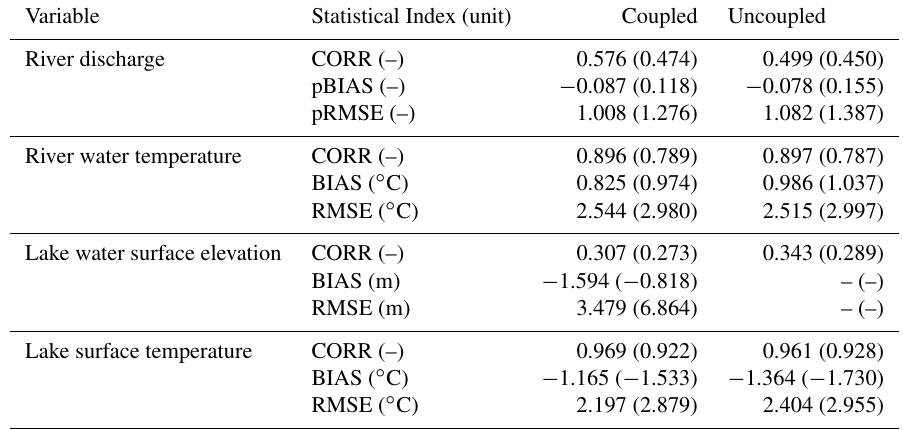
Table 5. Summary of reproducibility indices of coupled simulation. Values in the parentheses are those of the uncoupled (river-only for riverine and lake-only for lacustrine variables)